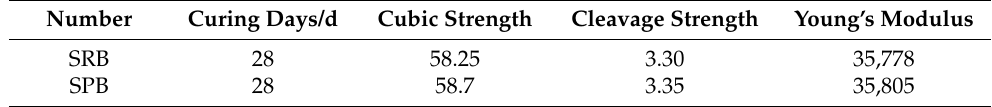
Table 1. Test strength of concrete (unit: MPa).